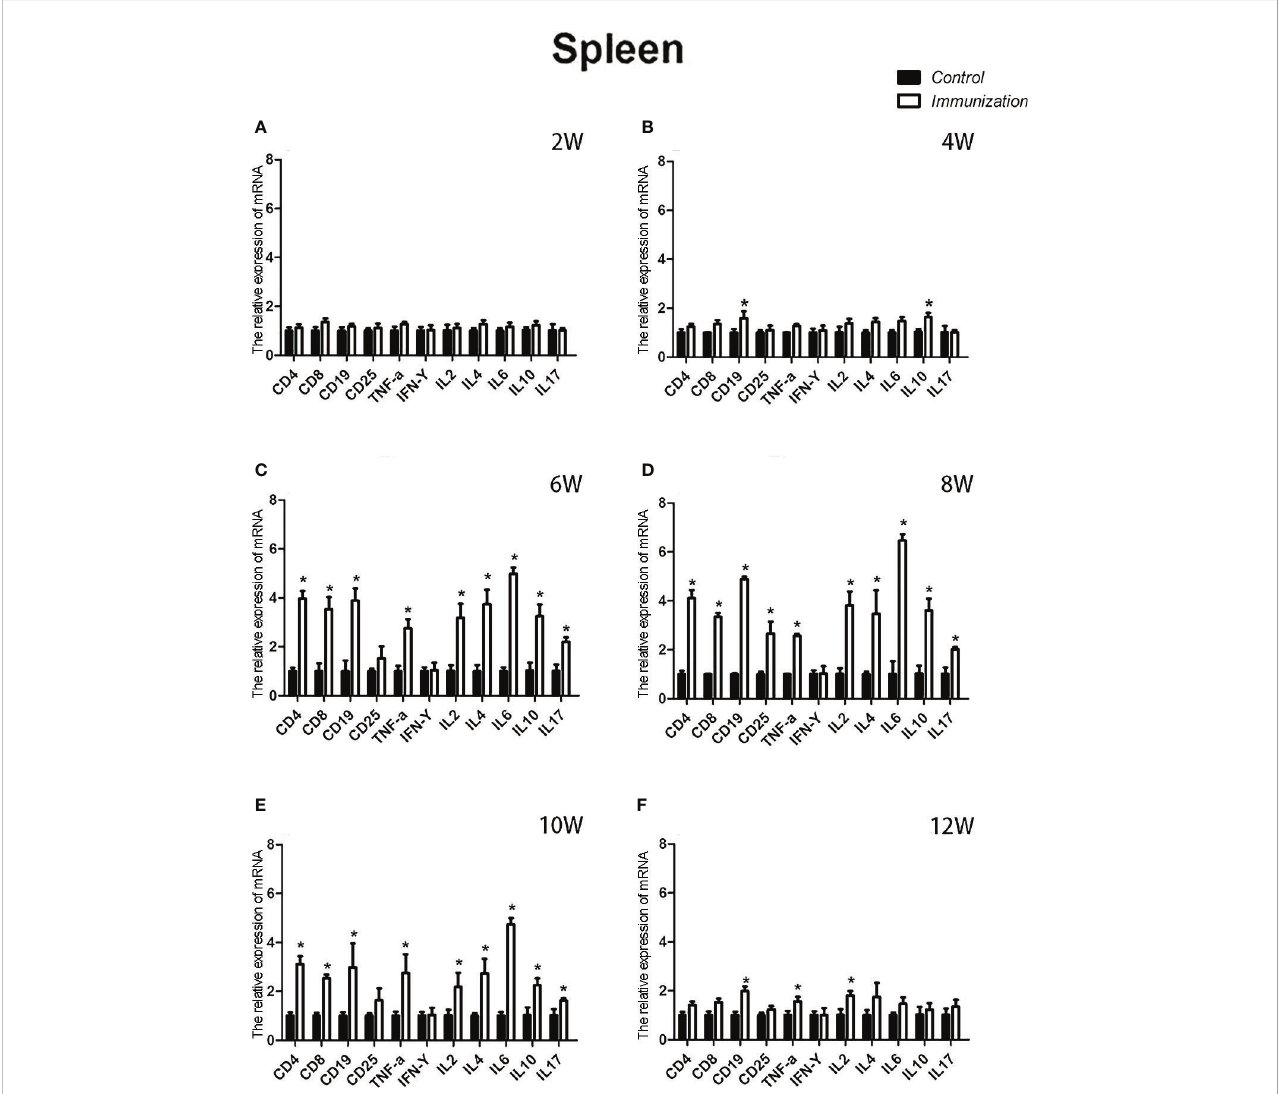
FIGURE 10 Mean (± SEM) of the effects of gonadotropin-releasing hormone (GnRH) immunization on mRNA expression of immunity-related genes in the spleen of the control (n = 35) and GnRH immunization groups (n = 35). (A-F) Indicate the detection time at different ages. * Indicates a signi fi cant difference ( P <